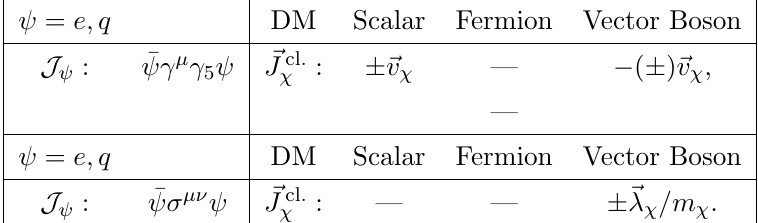
Table 4 . DM currents for the operators of tab 1 in the classical (cid:12)eld case as de(cid:12)ned in (3.31), cf. tab 3 for the particle regime. The signs correspond to a (cid:12)eld made of particles or antiparticles. (cid:6) The ansatz of eq. (3.30) selects the upper